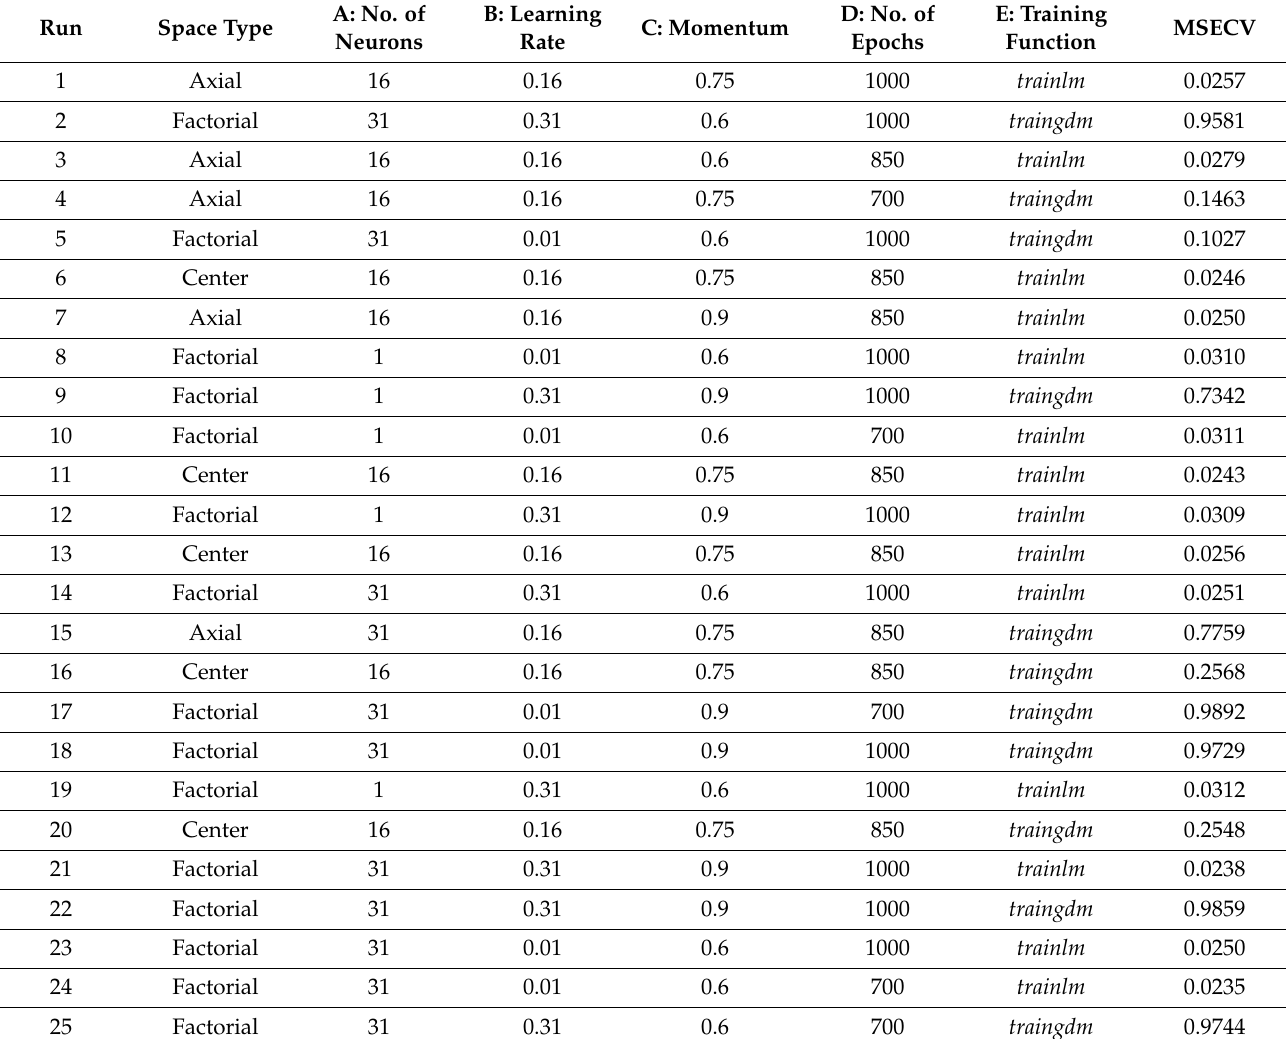
Table 3. MSECV results obtained by various conditions of network parameters using